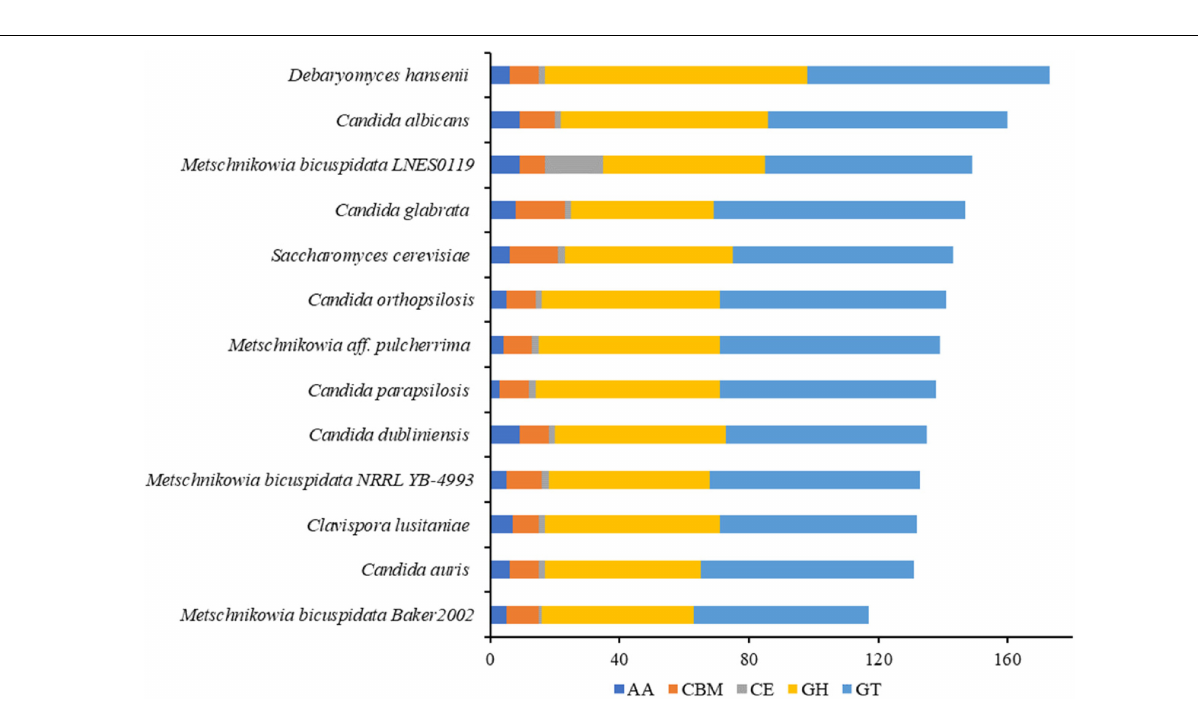
Frontiers in Microbiology |